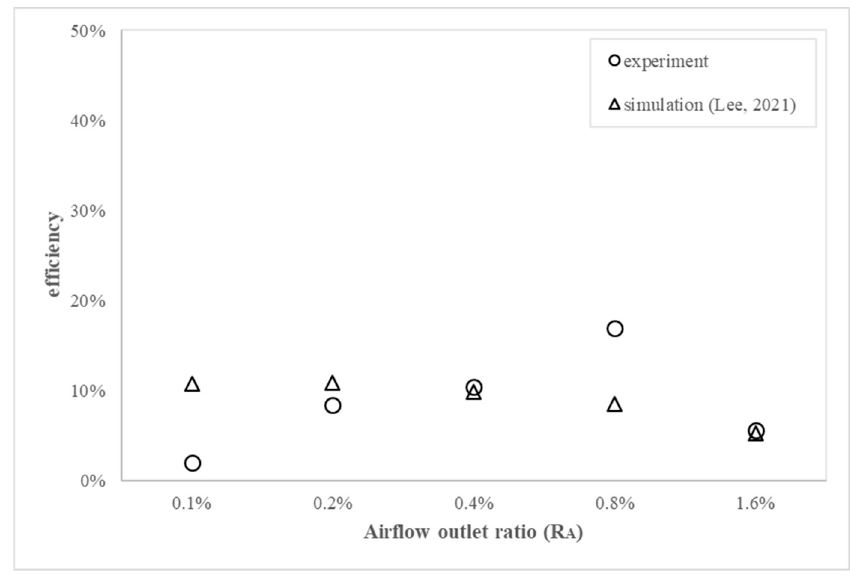
Figure 20. Comparison for the converting efficiency from the OWC various outlet ratios.